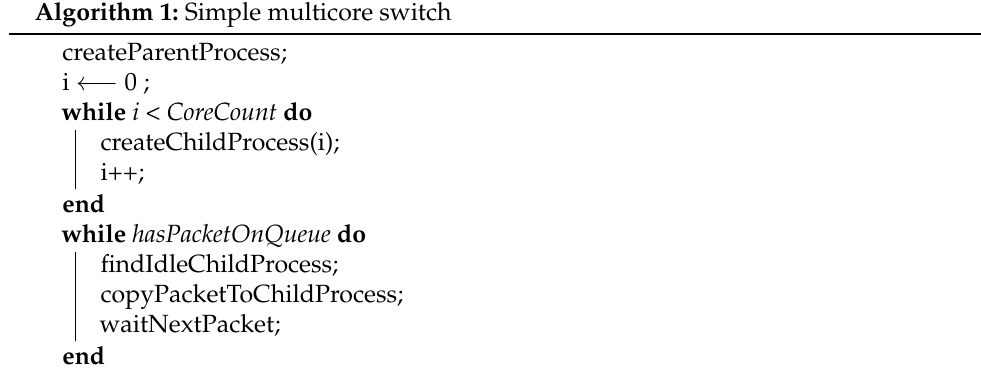
Figure 4. Ryu Simple switch implementation ( A ); and our multicore Ryu Implementation ( B ). Algorithm 1: Simple multicore